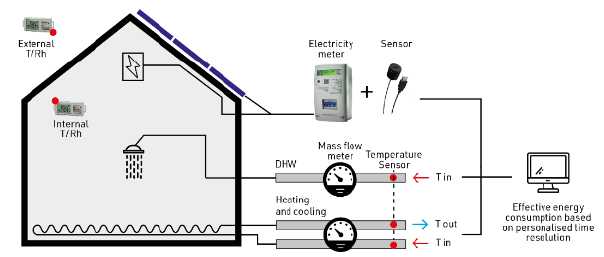
Figure 6. Advanced level: Configuration 6: dwelling with centralized domestic hot water, heating and cooling production. Source: elaborated by authors.